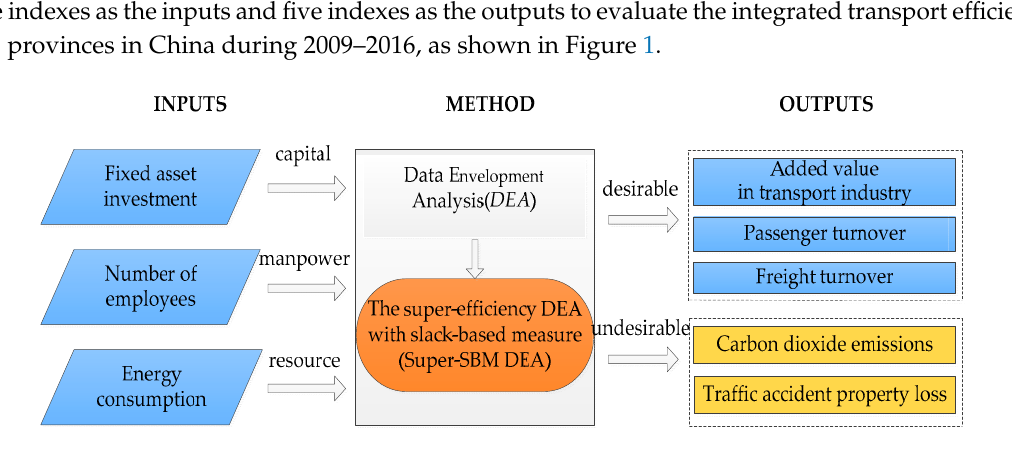
Figure 1. Super-efficiency slack-based measure model.